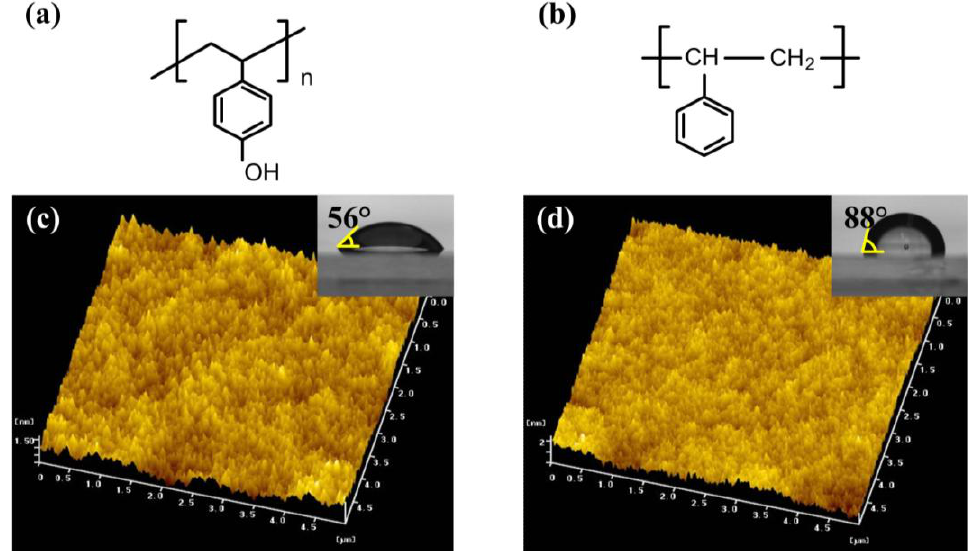
Figure 1. Chemical structures of (a) PVP and (b) PS. AFM images (5  m  5  m) of